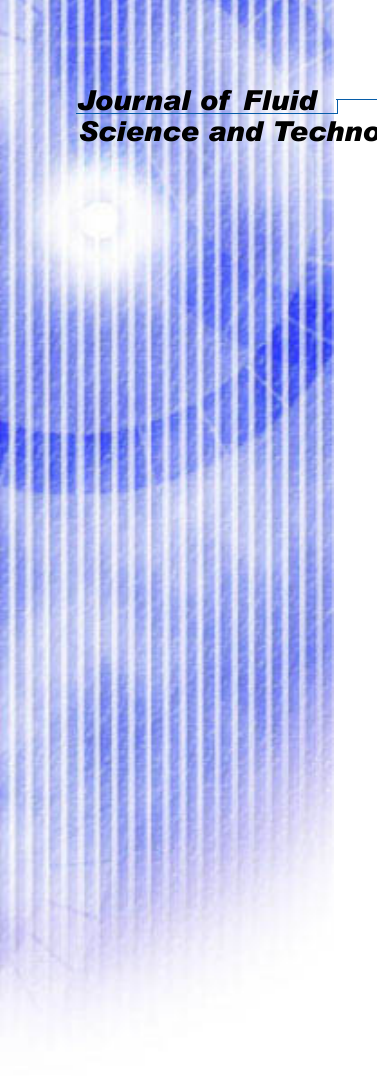
Fig. 19 Streamwise growth of integrated 1/4 subharmonic E.